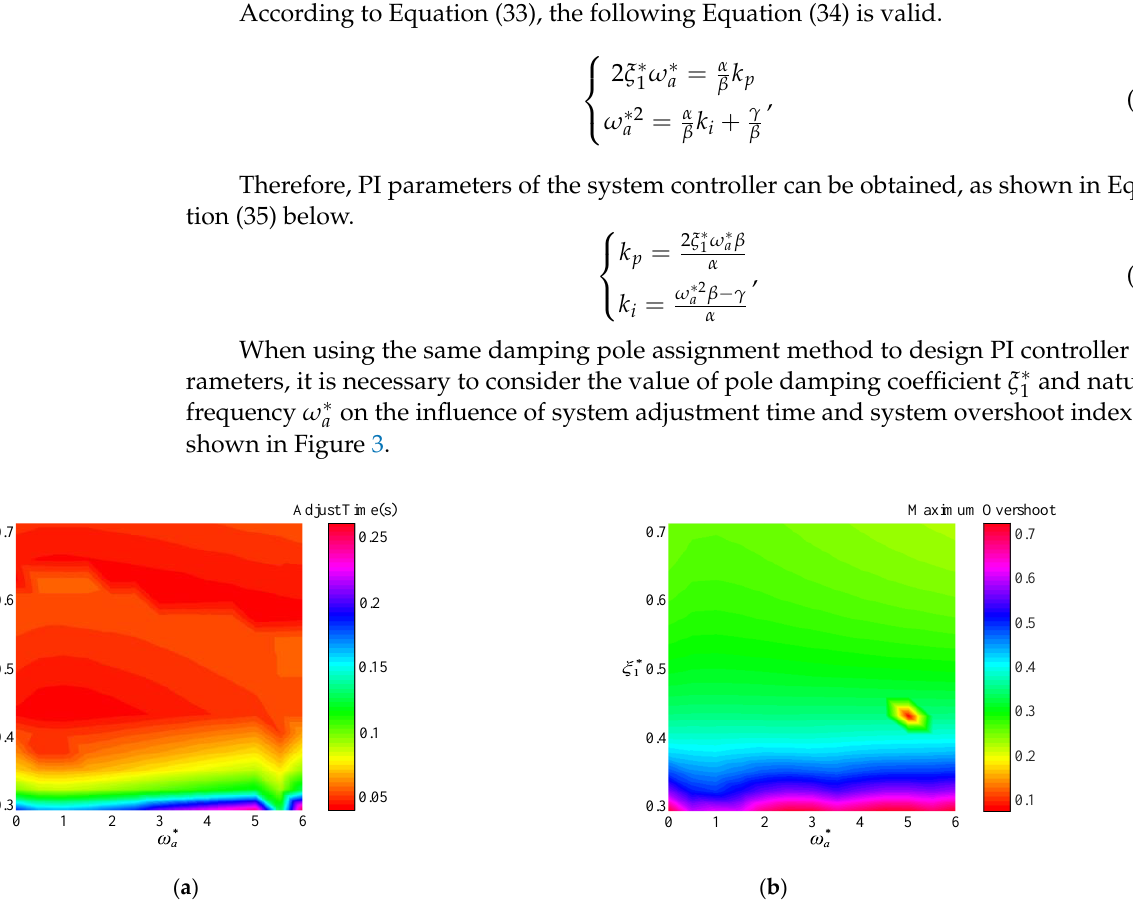
Figure 3. System evaluation index diagram of the same damping pole assignment method: ( a ) adjustment time; ( b ) system overshoot.